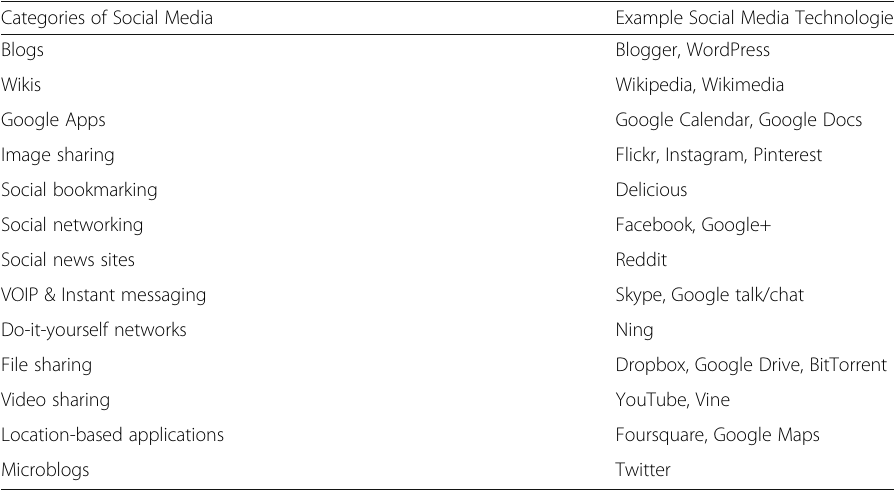
Table 1 Categories of Social Media